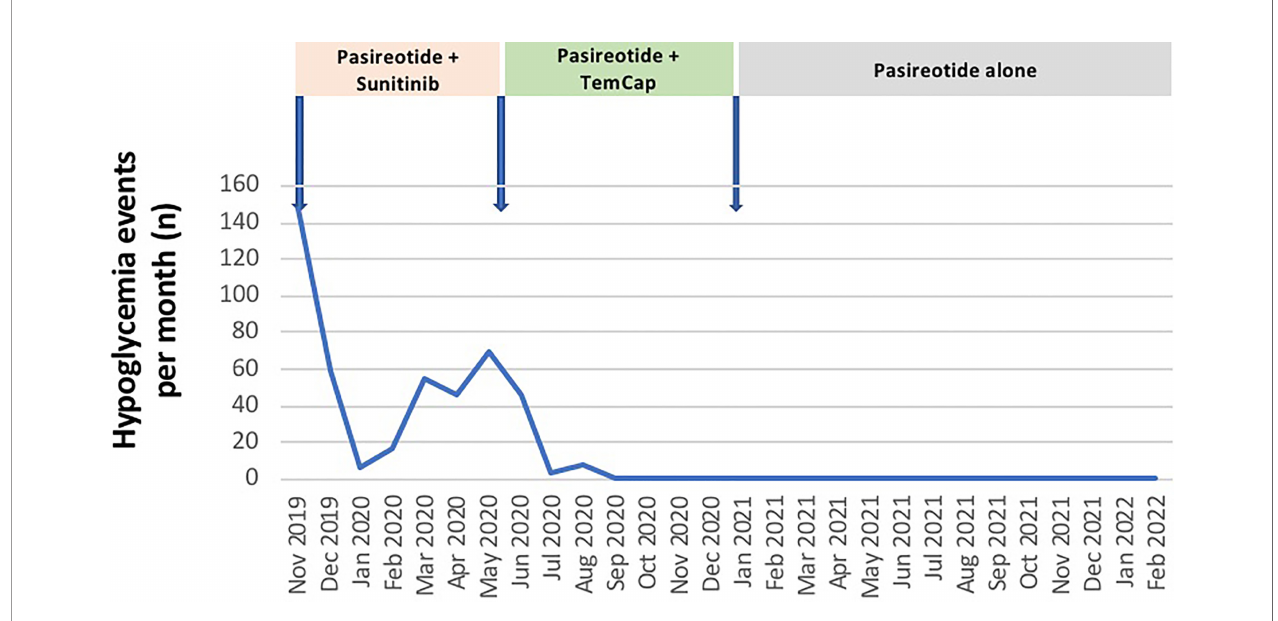
FIGURE 3 | Hypoglycemia events per month since beginning of Pasireotide.